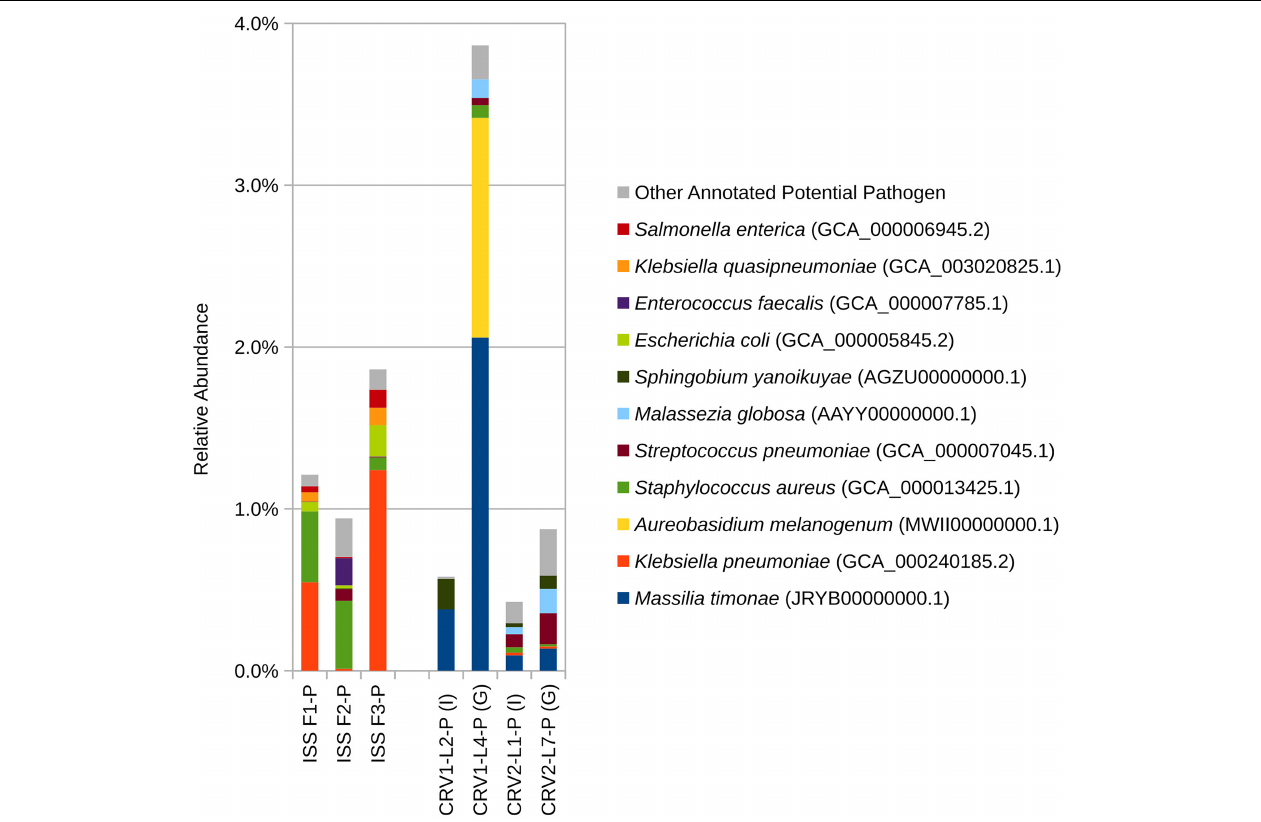
FIGURE 5 | Relative abundance of potential opportunistic pathogenic microorganisms detected in metagenomes generated from PMA treated samples collected from the internal (I) and ground support equipment (G) surfaces of CRV1 and CRV2 and three sampling events on the